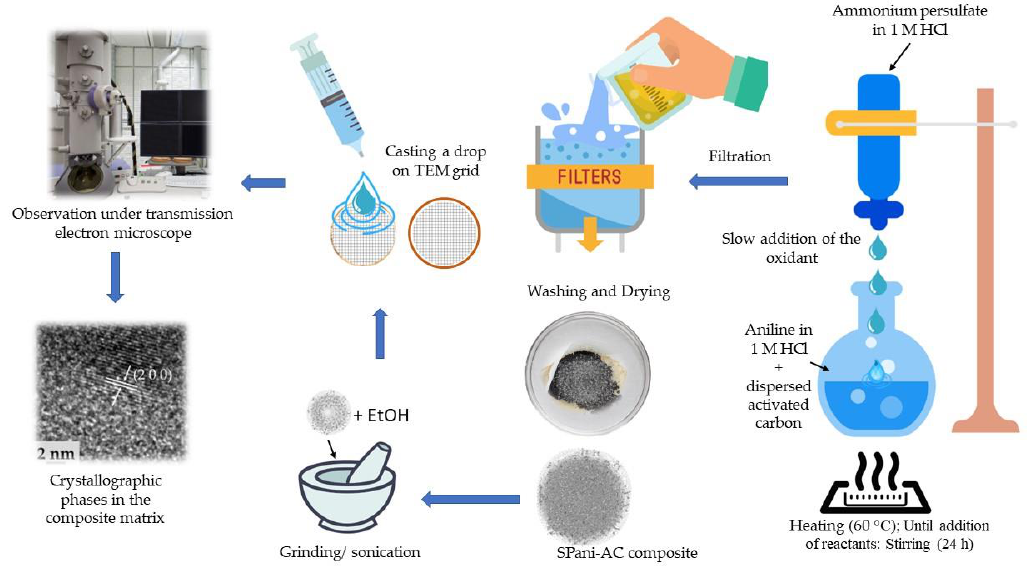
Figure 12. Schematic explaining synthesis of SPani-AC composite.